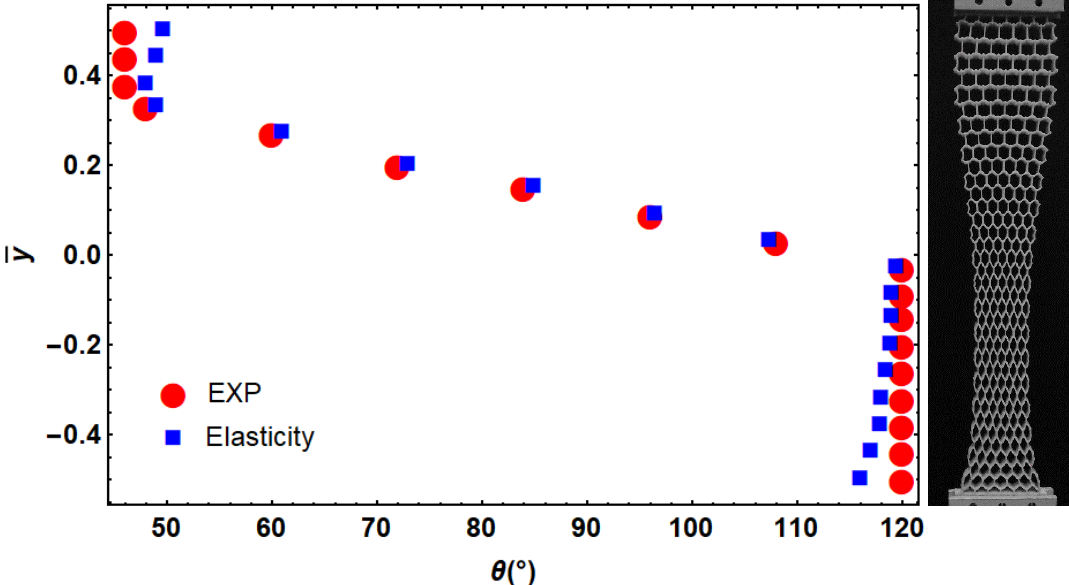
Figure 8. Comparison between the designed angle of cells with the presented approach and those obtained from experi- mental results presented in [17] for the desired deformation.